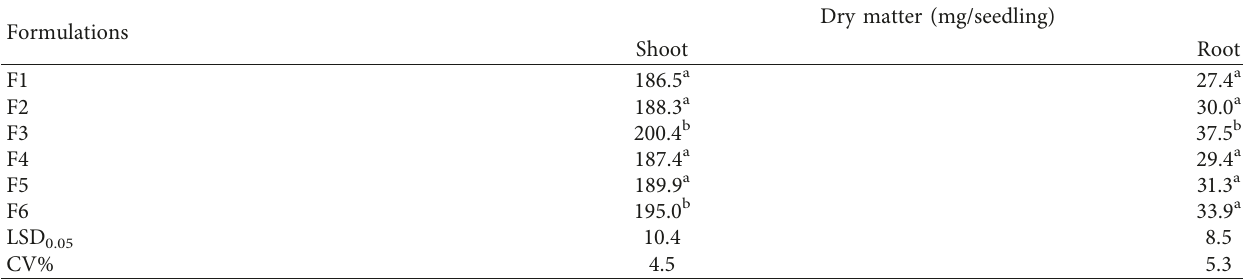
Table 4: Shoot and root dry mass of the soybean seedlings germinated from seeds treated with different nutrient formulations 7days after sowing.